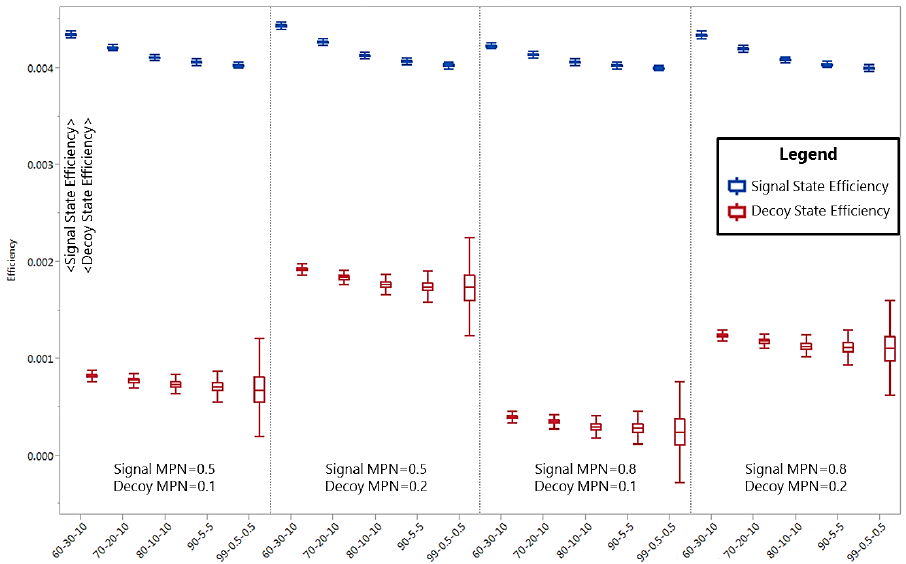
Figure 5. Simulation results are shown for the 50 km decoy state protocol configurations examined when subject to PNS attacks. In each configuration studied, the signal and decoy state efficiencies are statistically different 𝜂 𝑠𝑖𝑔𝑛𝑎𝑙 ≠ 𝜂 𝑑𝑒𝑐𝑜𝑦 ± Δ (outside expected variation tolerances).